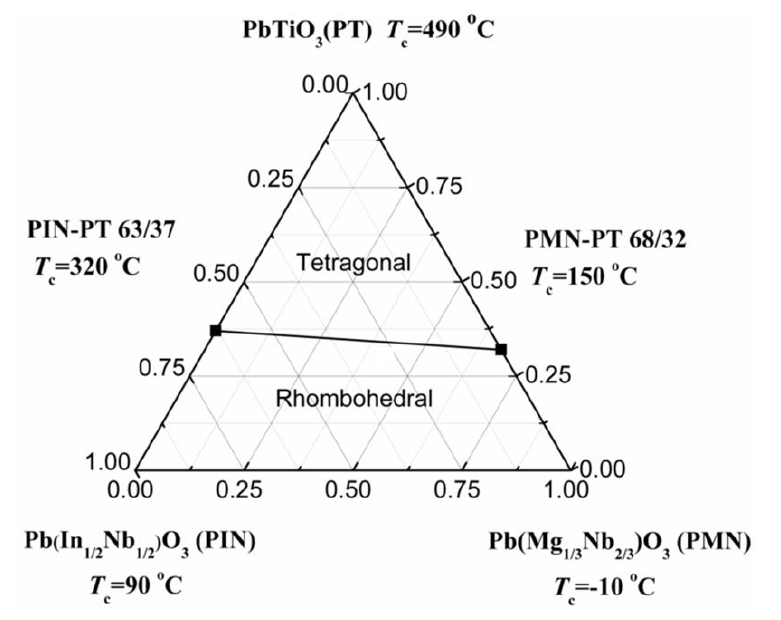
Figure 3. Phase diagram of PIN-PMN-PT ternary system (with permission from